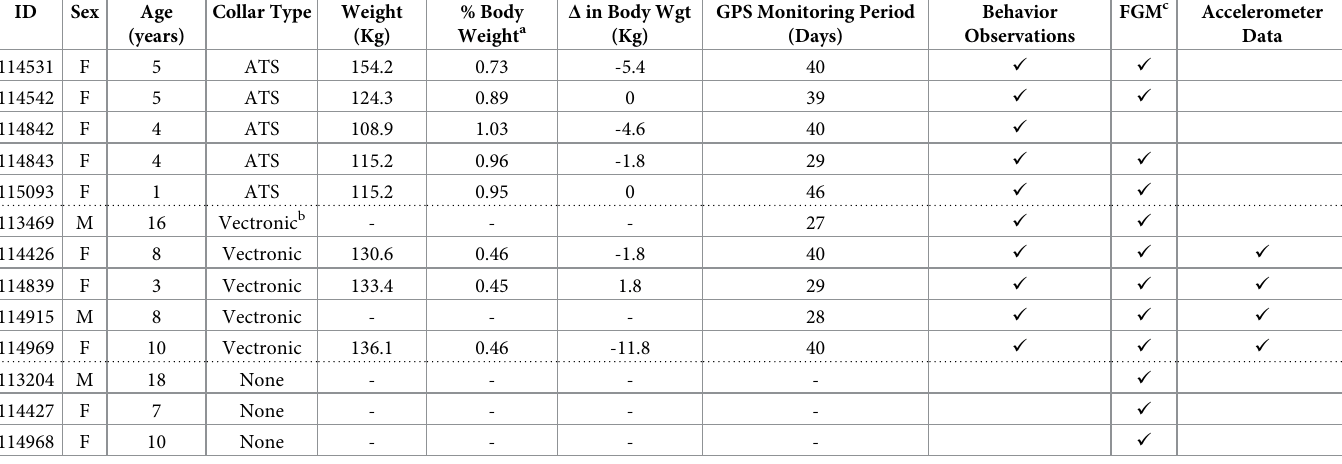
Table 1. Summary of scimitar-horned oryx ( oryx dammah ) included to evaluate short-term effects of GPS collars. Animals (ID) were fit with Advanced Telemetry System (ATS; model G2110E) and Vectronic Aerospace (Vectronic; model Vertex Plus) GPS collars. Control (non-collared) animals also listed (Collar Type: None). Change ( Δ ) in body weight compares animal weights on 03-Nov-2015 (Weight) and 15-Dec-2015. Percent (%) body weight of GPS collars based on collar weights of 1.1 Kg (ATS) and 0.6 Kg (Vectronic). Checkmarks ( ✓ ) indicate animal inclusion in study components. (-) Indicates data not